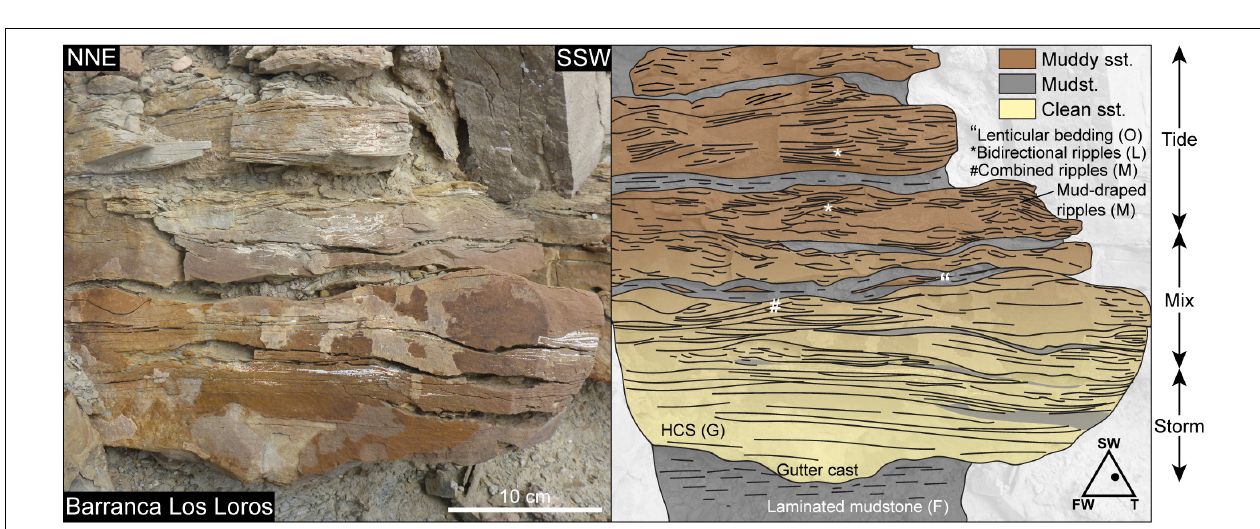
FIGURE 5 | Facies transition recorded at Barranca Los Loros ( Figure 1D ). Figure location is indicated in Figure 9 . Gradual transition from storm (yellow) to tidal (brown) deposits, shown by original picture (left) and overlay interpretation (right) . Yellow color corresponds to clean HCS sandstone (Facies G), brown color represents muddy sandstone, and gray color reflects laminated mudstone (Facies F); bracketed letters refer to Facies ID (cf. Table 1 ), ternary diagram bed plot included (modified from Dashtgard et al., 2012); SW, storm wave; FW, fair-weather wave; T,